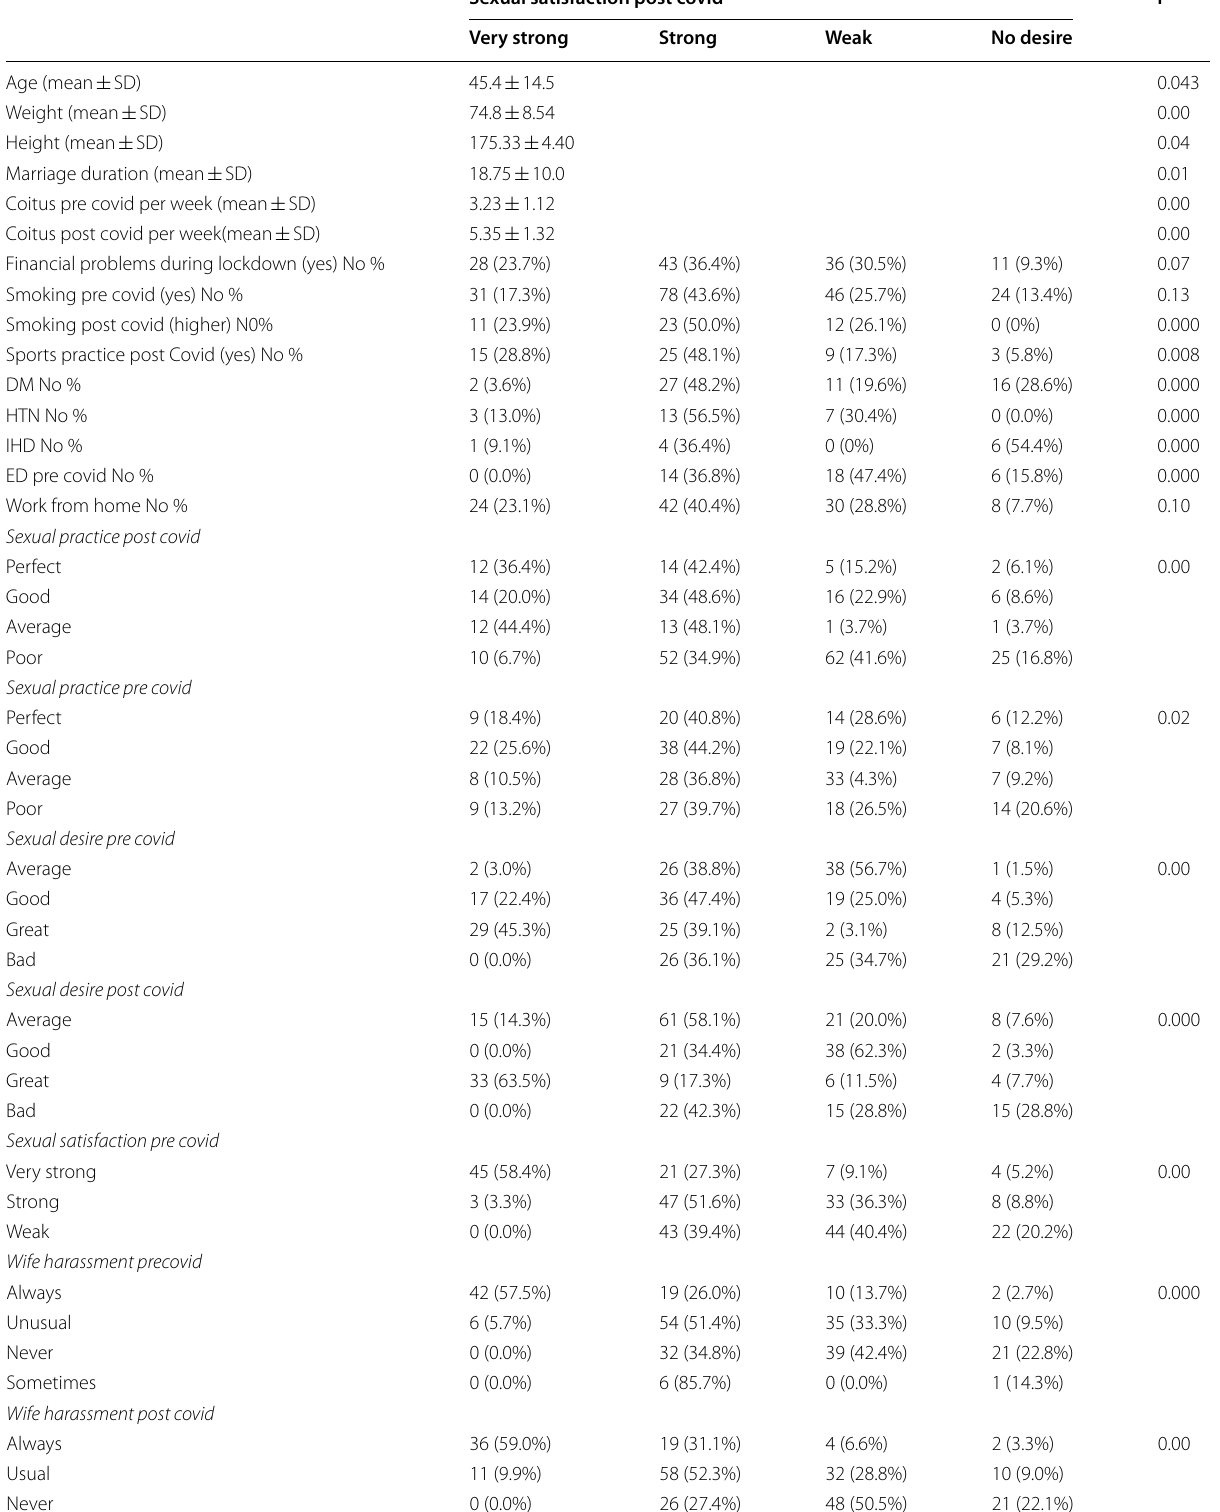
Sexual satisfaction post